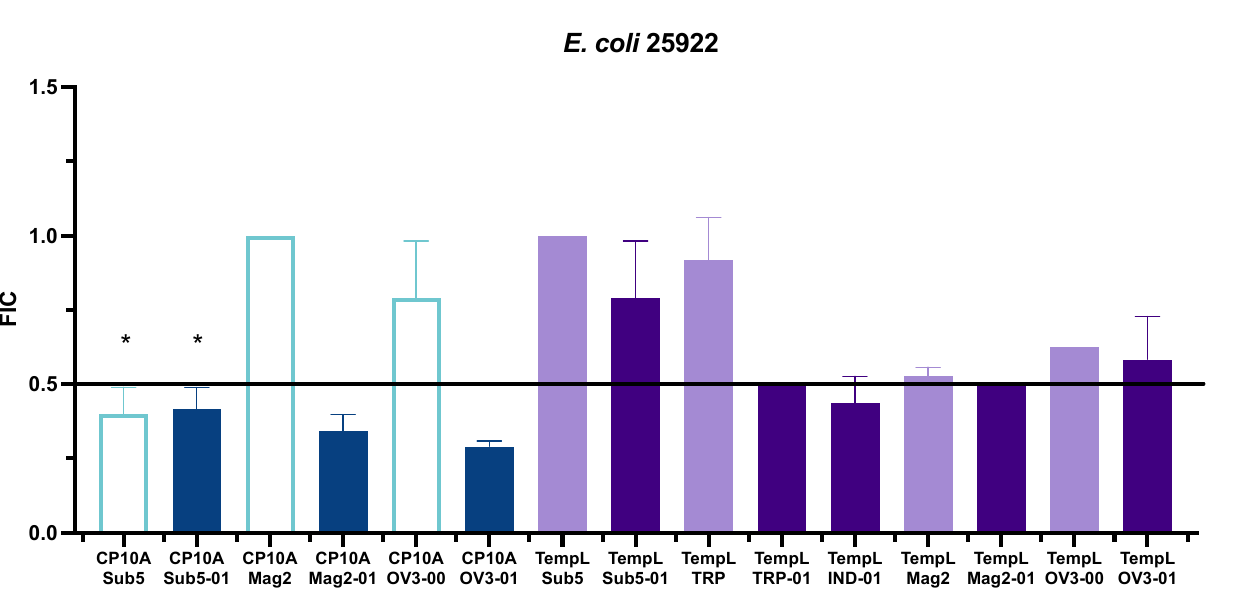
Figure 3. Representation of FIC values for interactions of CP10A (blue) and TempL (purple) in E. coli 25922. ATCUN-containing derivatives are represented as dark blue or dark purple, and parental peptides are represented as light blue or light purple. The line represents the threshold for synergy at 0.5. Starred data (*) are previously reported data from reference [11] for comparison.